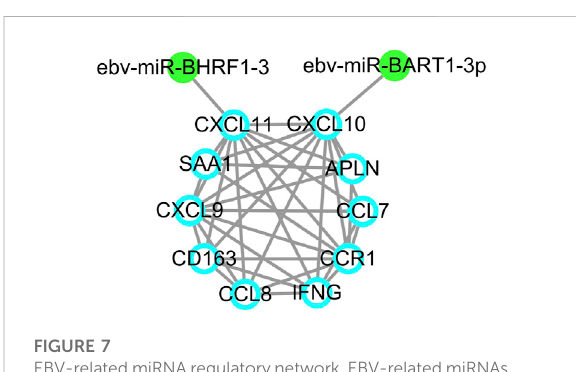
FIGURE 7 EBV-related miRNA regulatory network. EBV-related miRNAs are labeled in green dots while target genes are indicated by blue